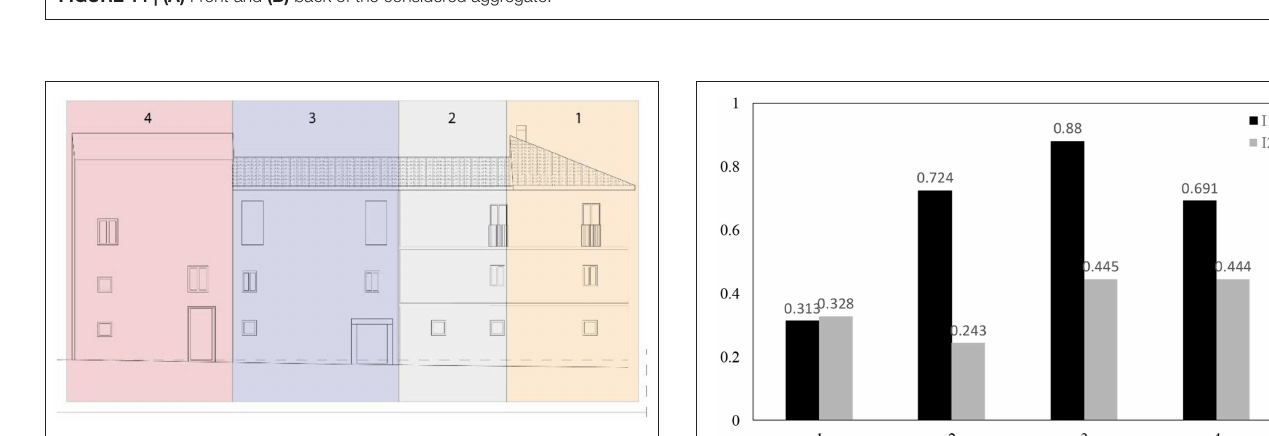
FIGURE 14 | (A) Front and (B) back of the considered aggregate.